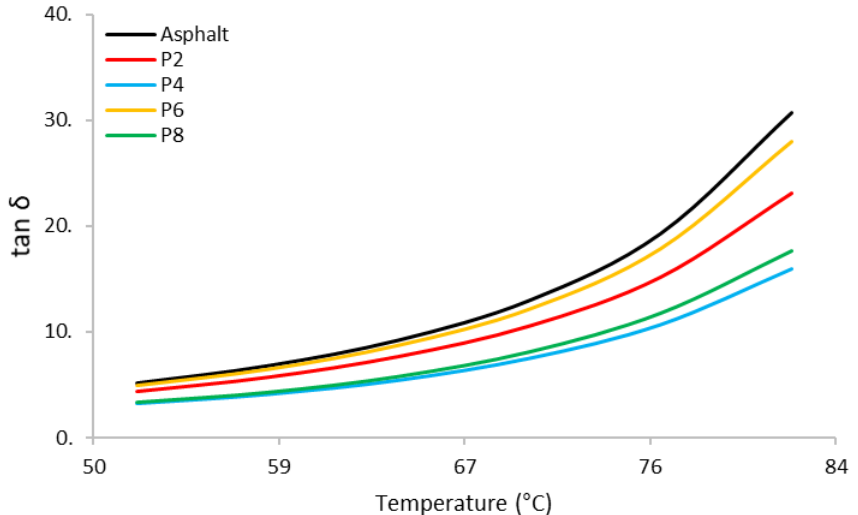
Figure 6. Isochronal plots of tan δ vs. temperature at 10 rad/s of asphalt modified by pistachio seed shell particles.